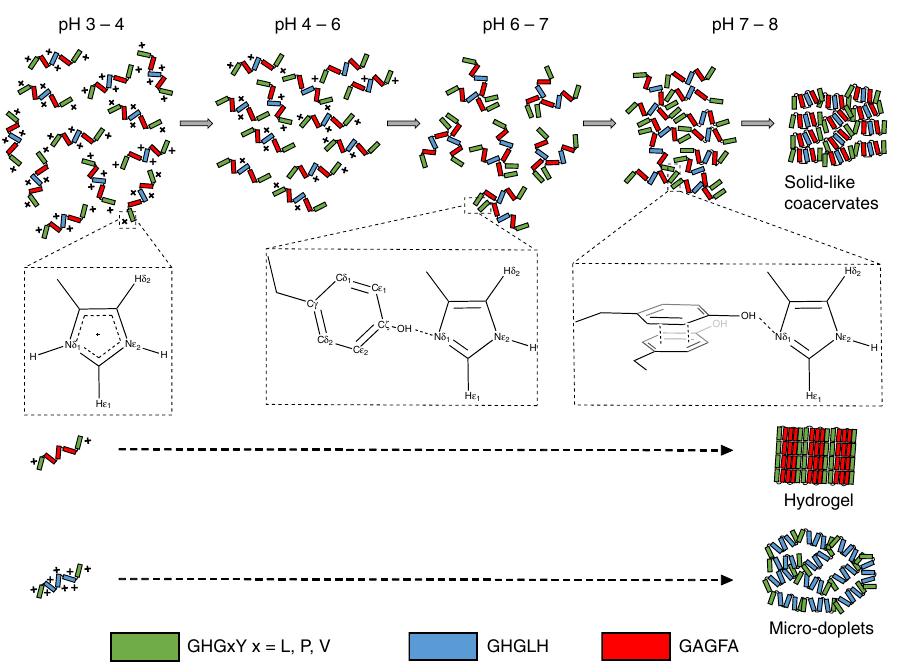
Fig. 7 Proposed model of pH-dependent LLPS of HBP-derived peptides. At pH 3 – 4 His residues are protonated, and the peptides form soluble oligomeric units due to electrostatic repulsion between positively charged His side chains. At pH 4 – 6 gradual deprotonation of His residues occurs, repulsive forces are weaker but still strong enough to keep the peptide oligomers soluble. At pH 6 – 7 transient interactions take place between His and Tyr residues located within GHGxY repeats (marked in green) leading to speci fi c peptide-peptide interactions that act as nuclei for LLPS. Further increase of pH above 7 leads to Tyr – Tyr intermolecular stacking and intra-molecular interaction of hydrophobic residues that all together trigger LLPS and the formation of microdroplets. If the central domain of the peptide is enriched with the hydrophobic motif GAGFA (marked in red) or with the His-rich motif GHGLH (marked in blue), LLPS is driven by the same sequence of molecular events but eventually leads to the formation of either a hydrogel or coacervate micro-droplets,